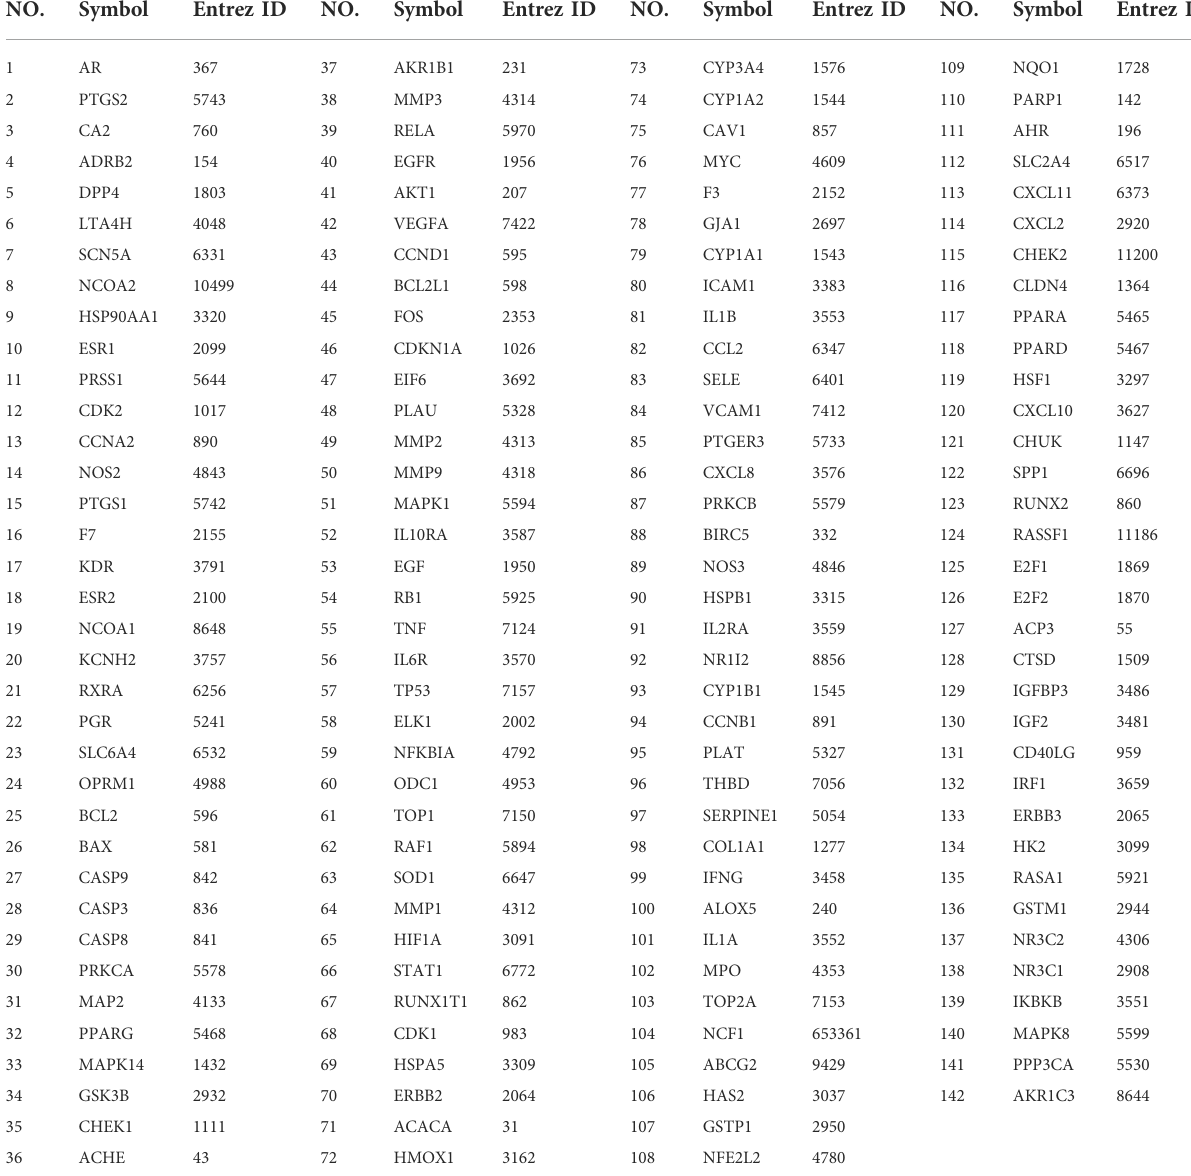
TABLE 2 Potential target genes of bioactive compounds in Mori Cortex for